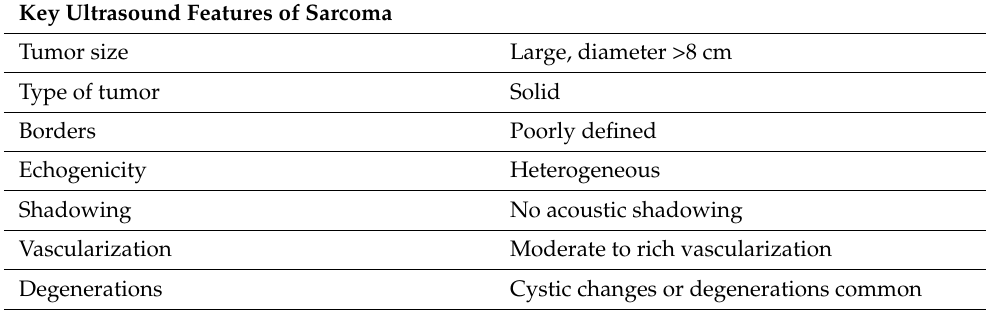
Table 3. Key features of sarcoma on